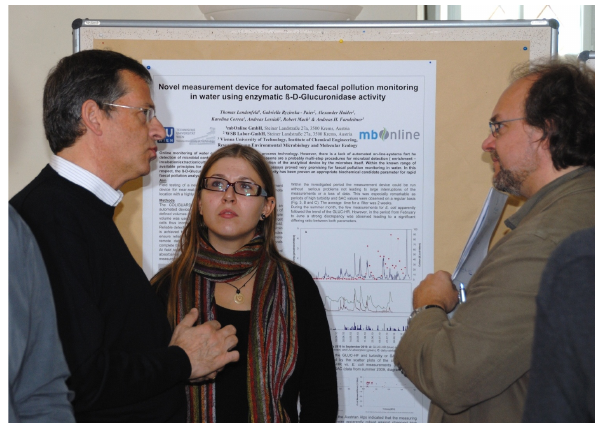
Fig. 5. Discussions during the annual